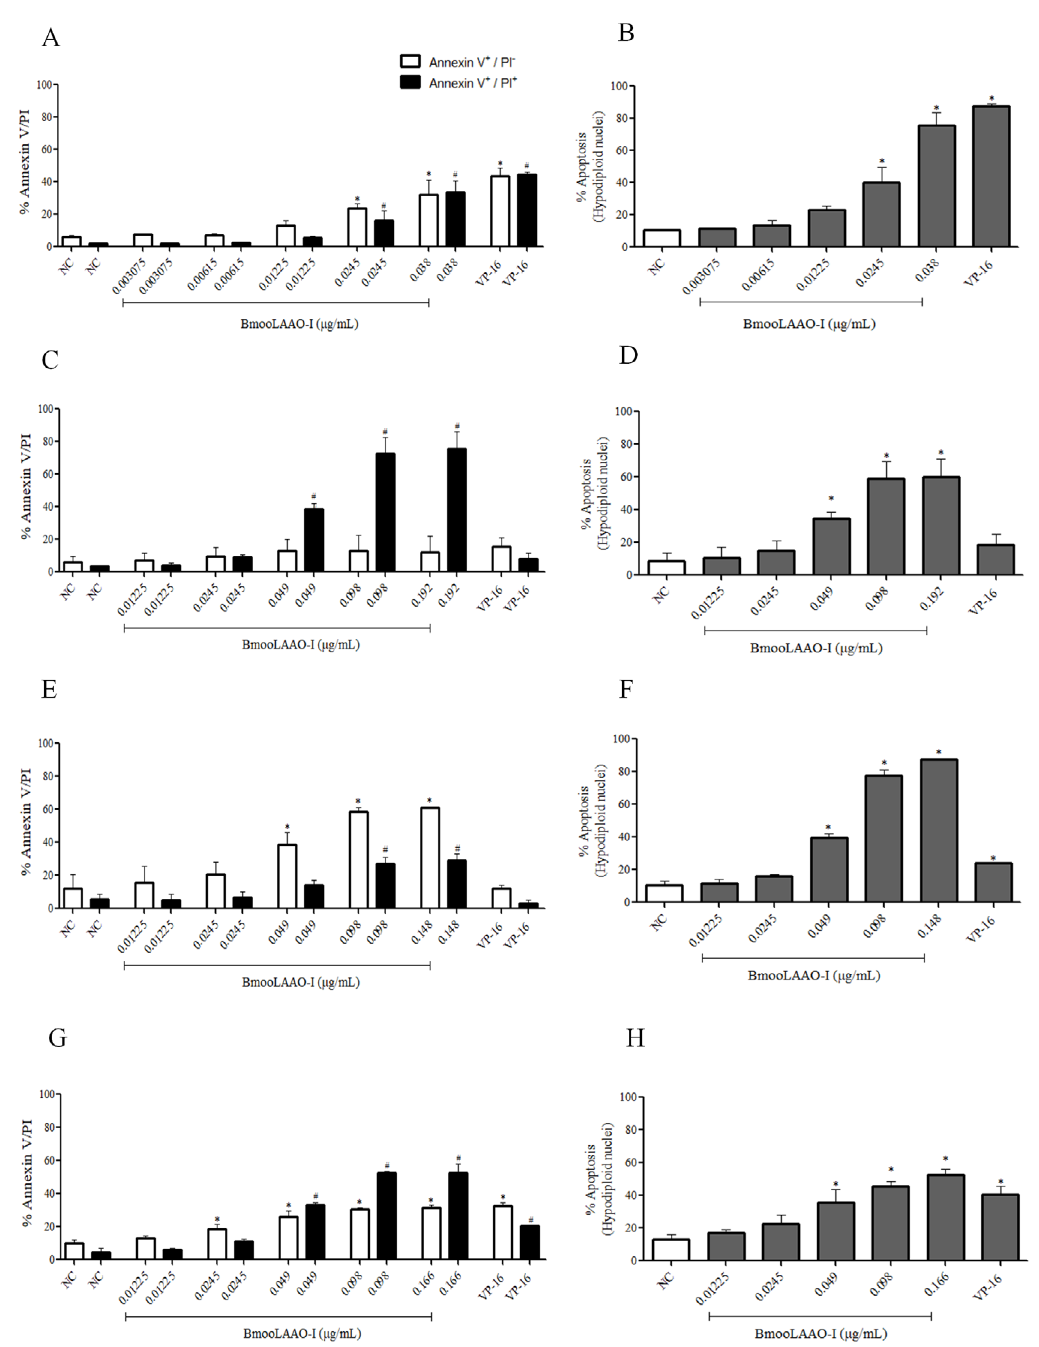
Figure 3. Quantification of apoptosis levels induced by BmooLAAO-I. The percentage of annexin V + /PI - (white bars) and annexin V + /PI + (black bars) was determined in (A) HL-60, (C) HL-60.Bcr-Abl, (E) K562-S, and (G) K562-R cells. The percentage of hipodiploid nuclei was determined in (B) HL-60, (D) HL- 60.Bcr-Ab, (F) K562-S, and (H) K562-R cells, using the hypotonic fluorescent solution method. Results are expressed as mean ± standard deviation of three independent experiments. NC: negative control (untreated cells); VP-16: etoposide. * p < 0.05 vs. NC (annexin V + /PI - and hypodiploid nuclei); # p < 0.05 vs. NC (annexin V + /PI + ) (one-way ANOVA combined with the Tukey’s post-hoc